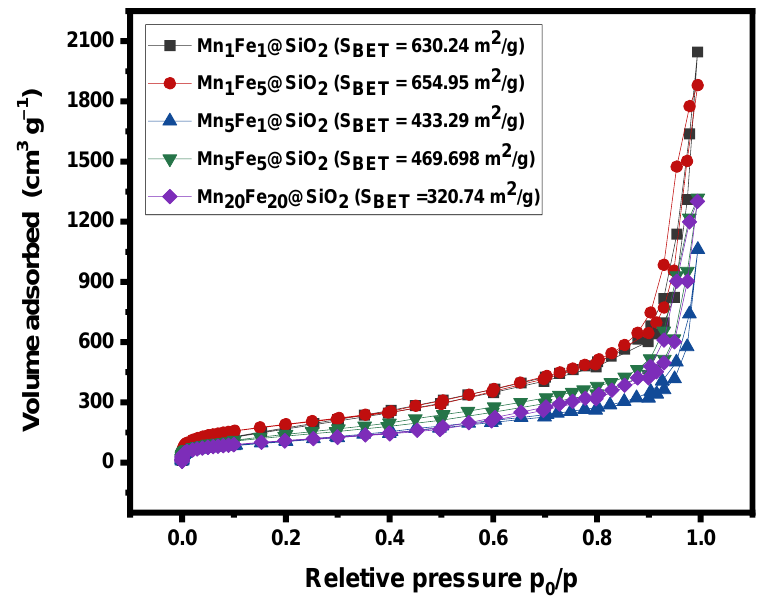
Figure 4. N 2 adsorption-desorption isotherms.